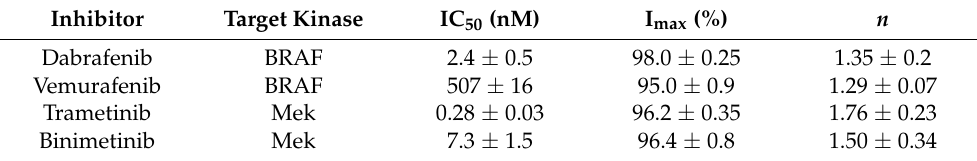
Figure 1. Inhibition of DU-4475 cell viability by different protein kinase inhibitors. Cell treatment and viability assays were conducted as described in the Materials and Methods. The cells were treated with each drug at four concentrations and the relative cell viability for each treatment was normalized to the control treatment of 1% DMSO. ( a ) Akt inhibitors. ( b ) Cytosolic PTK inhibitors. ( c ) Receptor PTK inhibitors. ( d ) BRAF and Mek inhibitors. Table 3. Inhibition 1 parameters of BRAF and Mek inhibitors on DU-4475